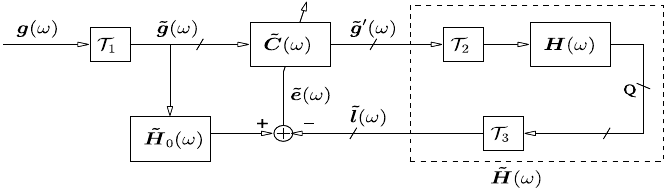
Figure 4. The listening room compensation using WDAF (wave-domain adaptive filtering). The free-field transformed loudspeaker signals (cid:101) g are used in a reverberant room with the filter matrix (cid:101) C to compensate the RTFs in matrix (cid:101) H , T 1 , T 3 and T 2 represent the forward and backward WDAF, respectively.